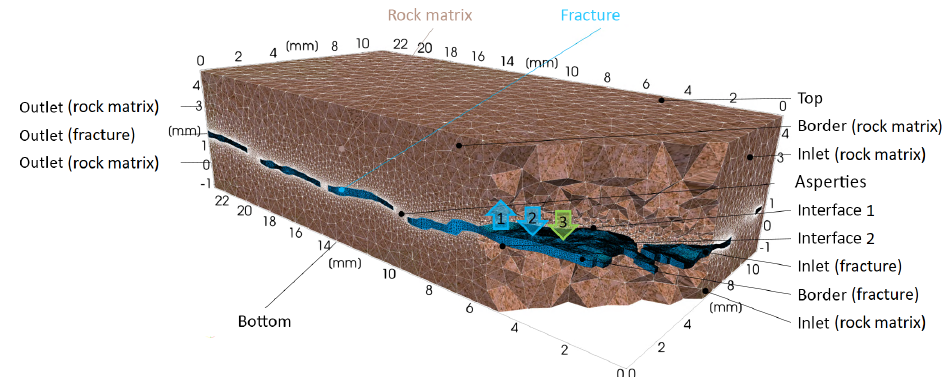
Figure 4. Definition of 3-D domains, all physical surfaces, and interfaces between the fracture and the surrounding rock